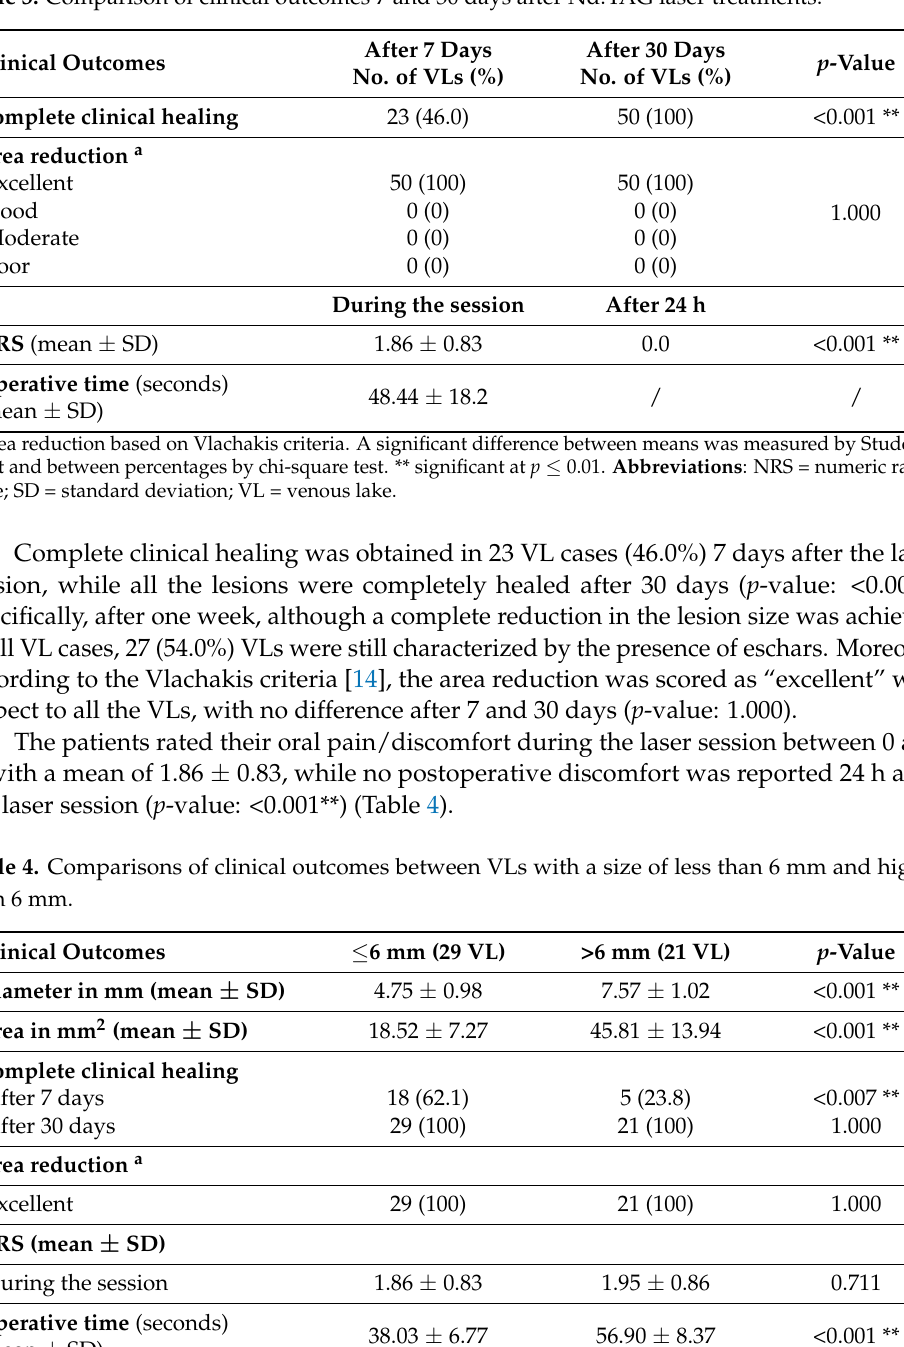
Table 3. Comparison of clinical outcomes 7 and 30 days after Nd:YAG laser treatments.